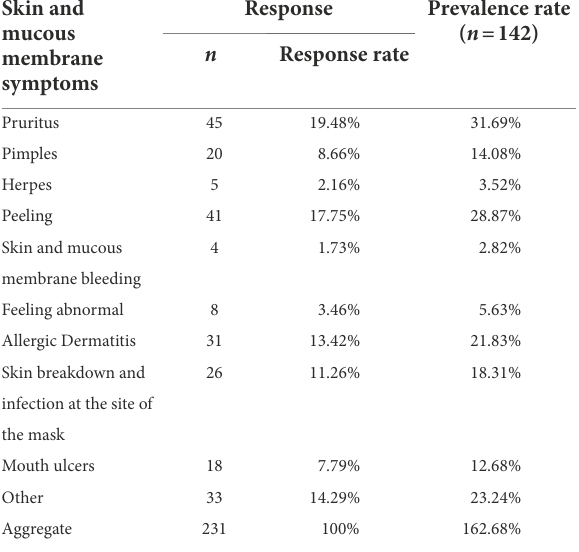
TABLE 4 Skin mucosal symptoms.